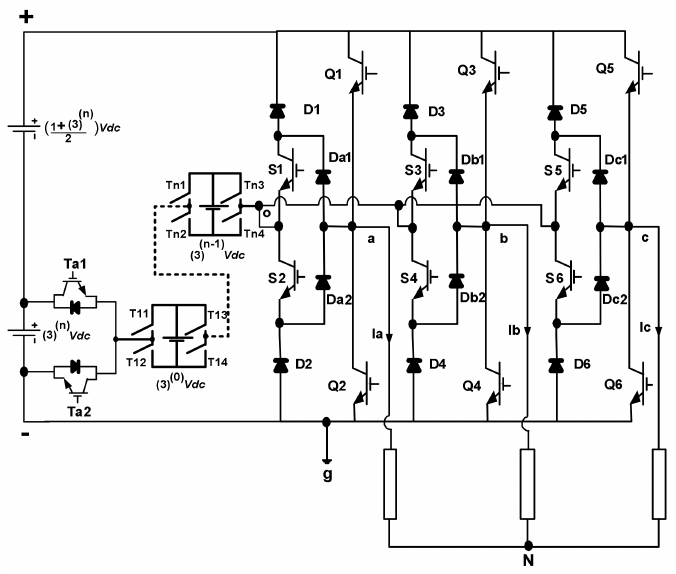
Figure 2. Proposed structure of three-phase N -level multilevel